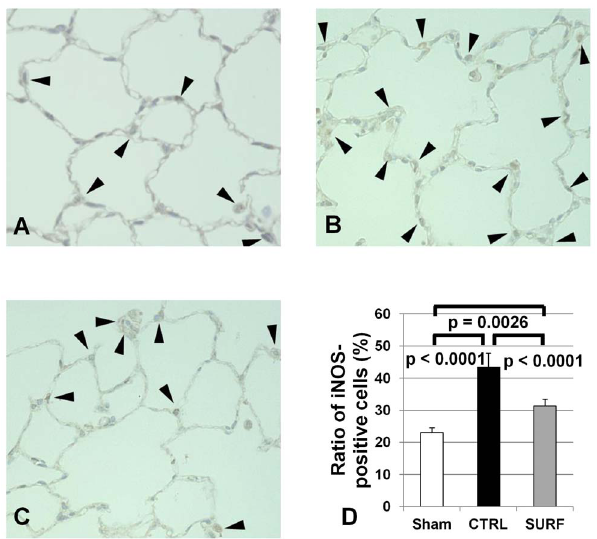
Figure 6. Immunohistochemical staining for iNOS (original magnification 400 6 ). (A) Sham group. (B) CTRL group. (C) SURF group. Arrows indicate iNOS positive cells. The ratio of iNOS-positive cells to total cells was significantly lower in the SURF group than in the CTRL group (D). All values are expressed as the mean 6 SD.